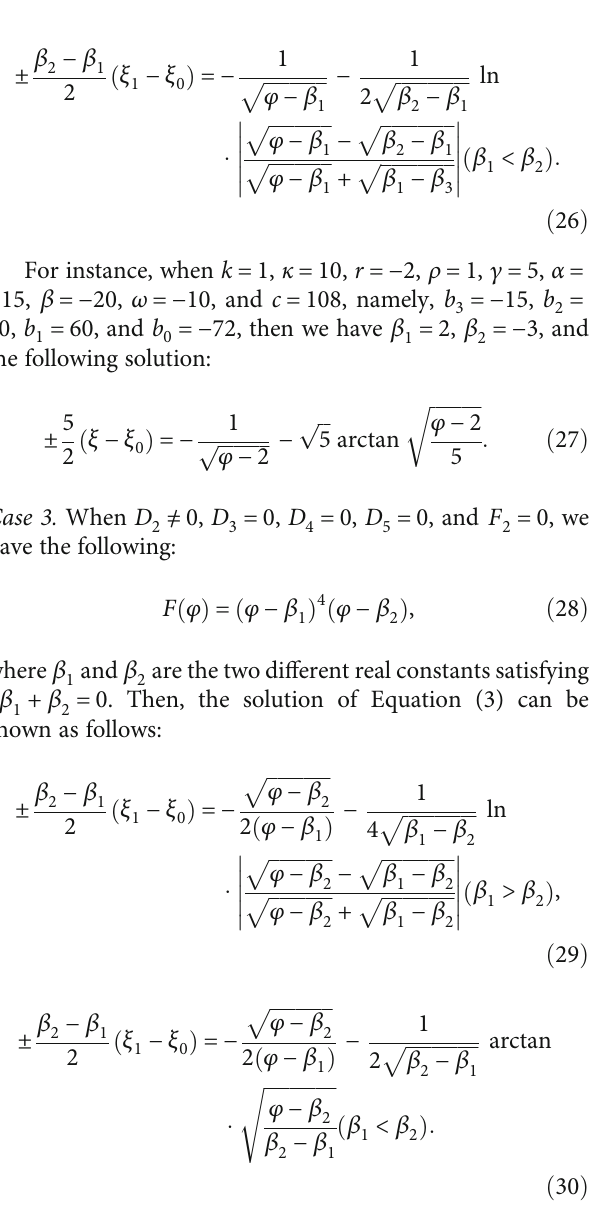
ffiffiffiffiffiffiffiffiffiffi p φ + 4 ffiffiffiffiffiffiffiffiffiffi p 2 φ − 1